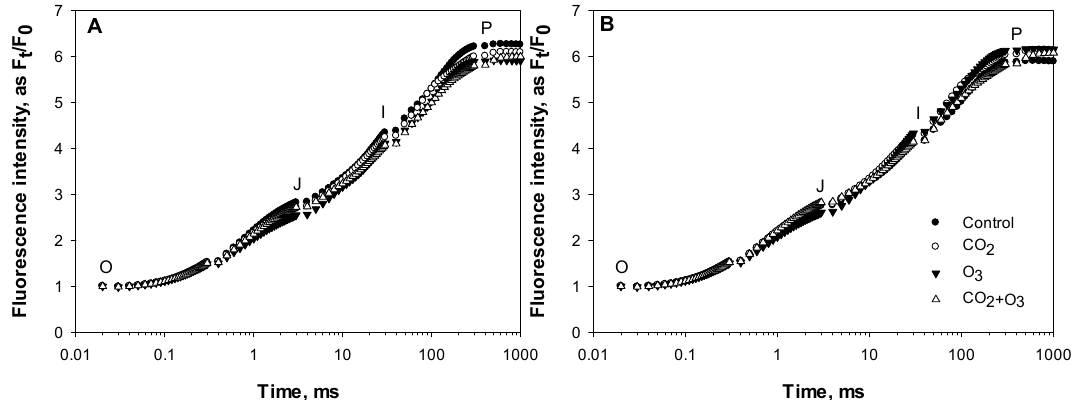
Figure 1. Average (of all weeks) chlorophyll (Chl) a fluorescence transients of canola leaves exposed to elevated CO 2 , O 3 and CO 2 + O 3 under well-watered ( A ) and water-stressed conditions ( B ).